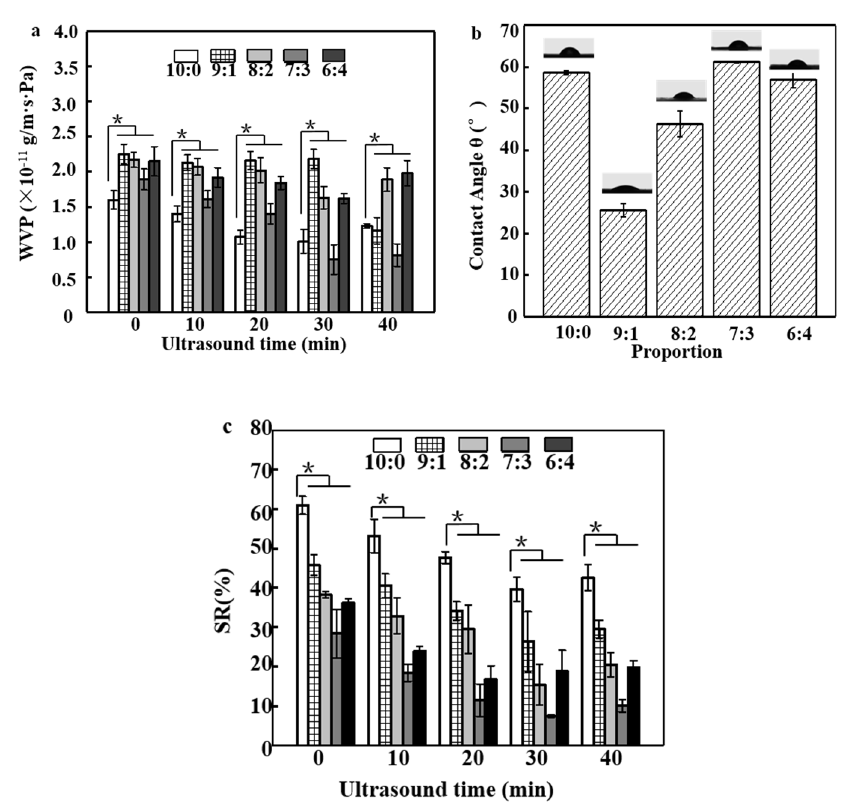
Figure 2. ( a ) Water vapor permeability (WVP) of SA/AgNPs/APP composite film SA/APP and under different ultrasonication times; ( b ) the contact angle of SA/AgNPs/APP (ultrasound time 30 min) composite film with different addition ratios, ( c ) swelling ratio (SR) of film (* p < 0.05, n = 5).